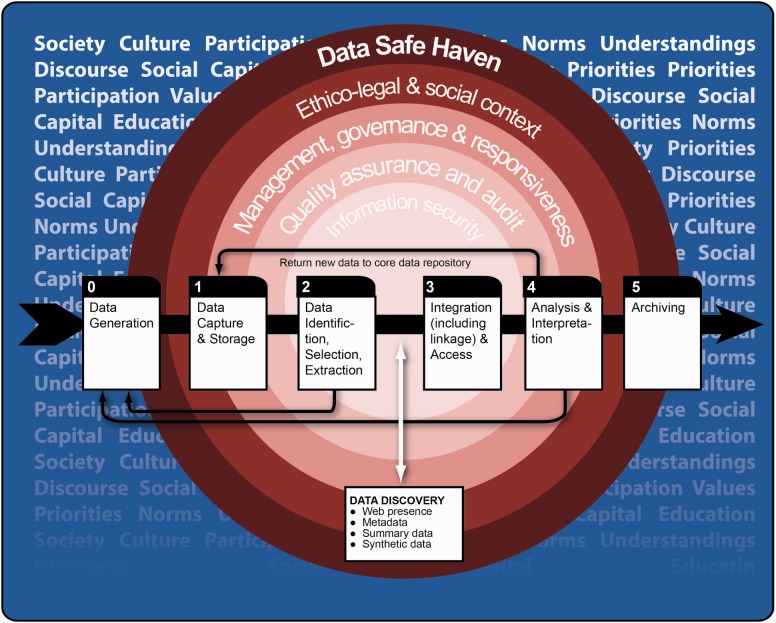
The data pipeline